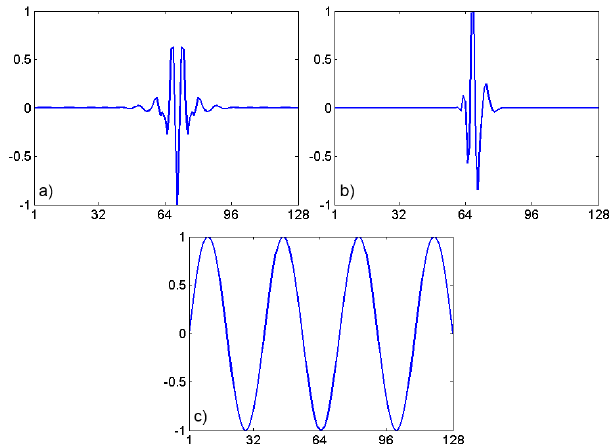
Figure 1. (a) Discretized Meyer basis function for a particular scale and translation; (b) Daubechies (4 tap) basis function with the same scale and translation as (a ); (c) a Fourier sinusoid component of the spherical harmonic basis functions. Basis functions are shown normalized to one and are interpolated for ease of